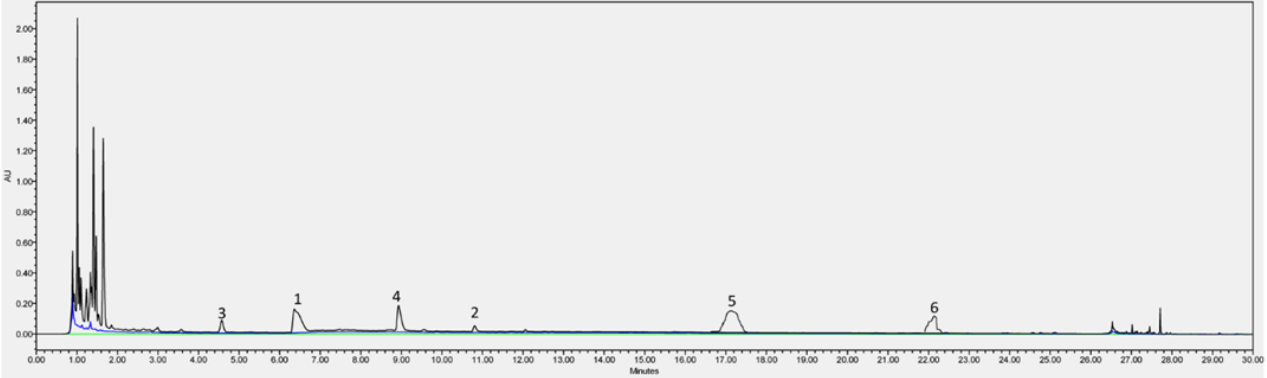
Figure 2. Comparison of flavonoids (1—naringenin, 2—vitexin, 3—rutin, 4—quercetin, 5—apigenin, 6—kaempferol) UPLC chromatograms: Ps (green line), Io (black line), Ba (blue line). Table 2. The phenolic acids concentration of 7 fungal isolates ( mg/kg DM in mycelium ). Table 4. The antioxidant activities of methanol-water extracts of the obtained mushroom isolates measured by reaction with the radical ABTS cation and the free phenolic acids (FPA)